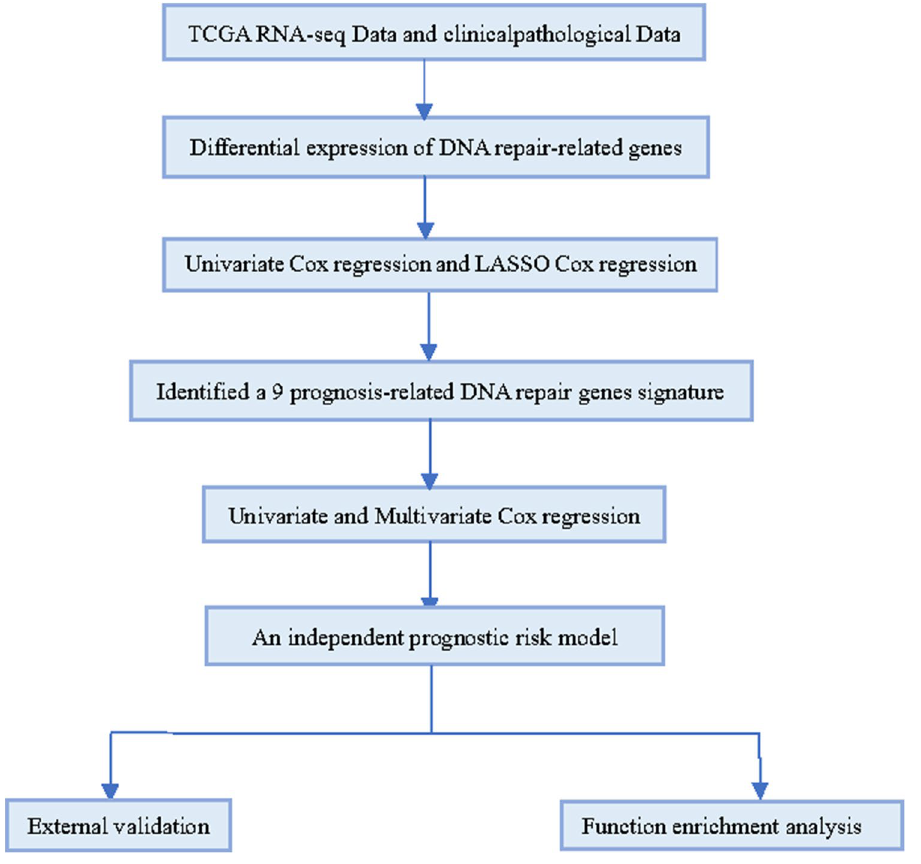
Figure 1. The flowchart of the research